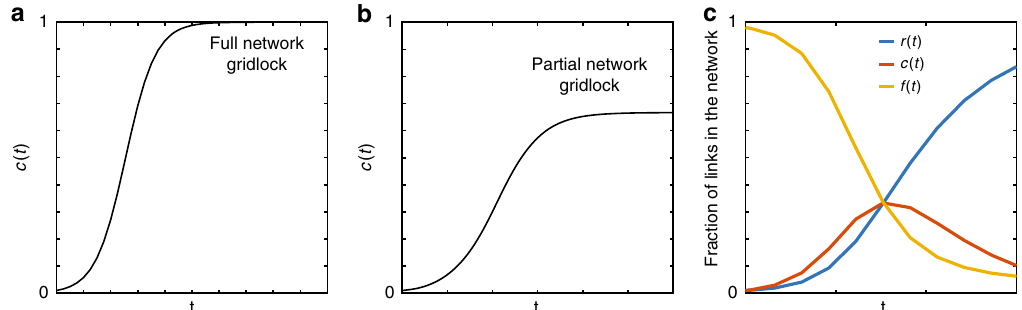
Fig. 2 Describing temporal evolution of congestion. Two-state model of congestion propagation in a network: fraction of congested links c ( t ) vs. time resulting in a full network gridlock described by a variation of the SI model and b partial network gridlock described by a variation of the SIS model. c Three- state model of congestion propagation and dissipation in a network, analogous to the SIR model subject to a time-varying loading – unloading demand pro fi